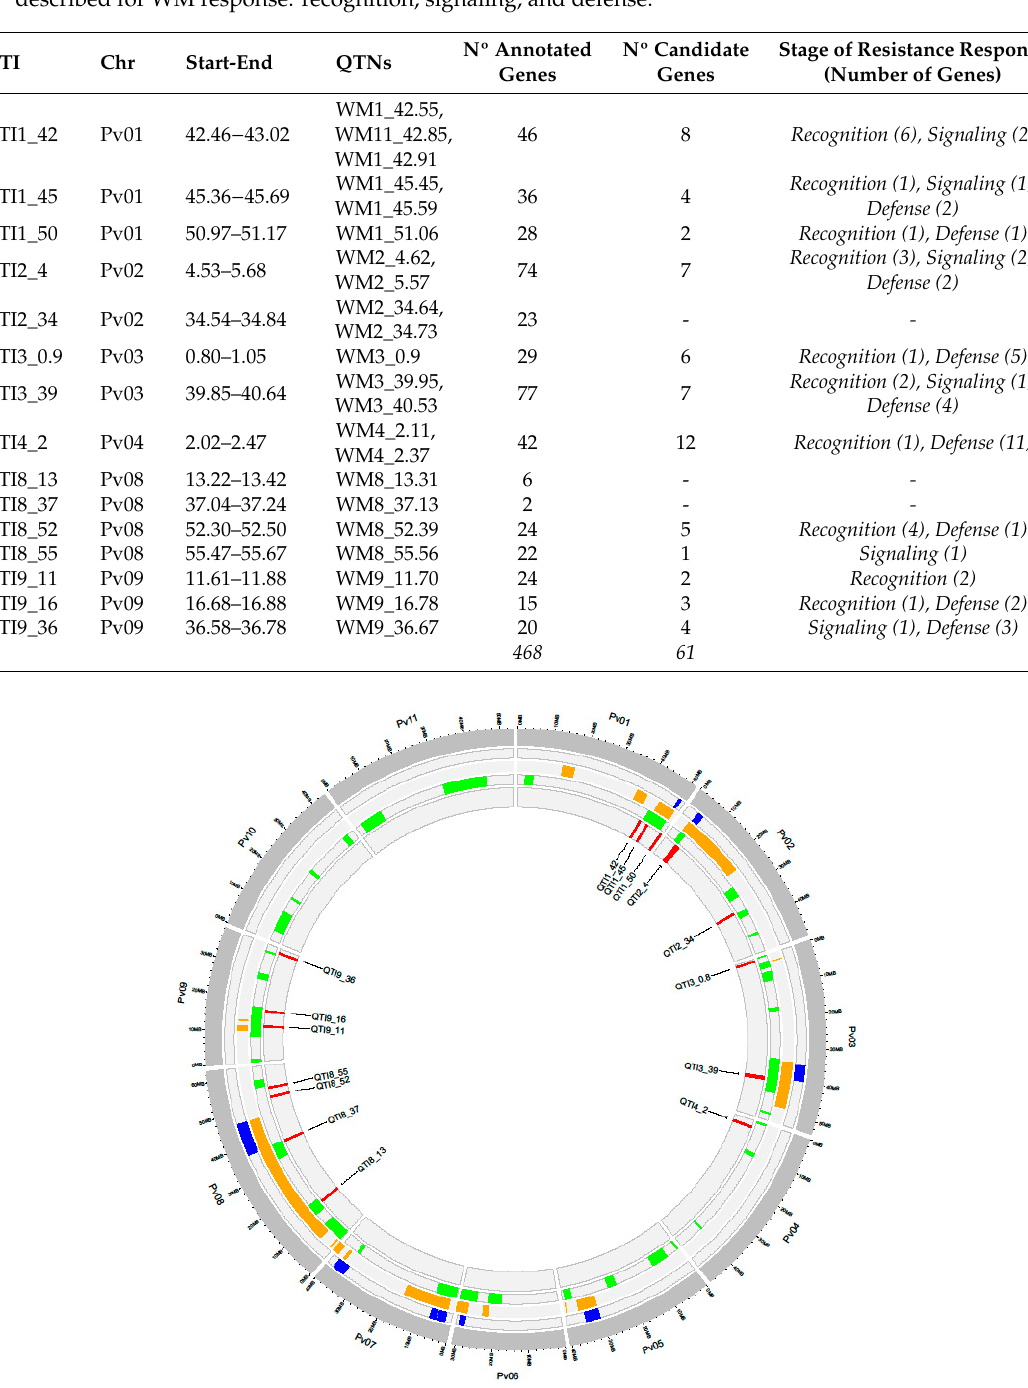
Figure 3. Circos plot showing the overlapping between WM quantitative trait intervals (QTIs) identified in this work (red track) and WM meta-quantitative trait loci (QTLs) (dark blue track), QTLs (orange track), and quantitative trait nucleotides (QTNs) (green track) previously described.